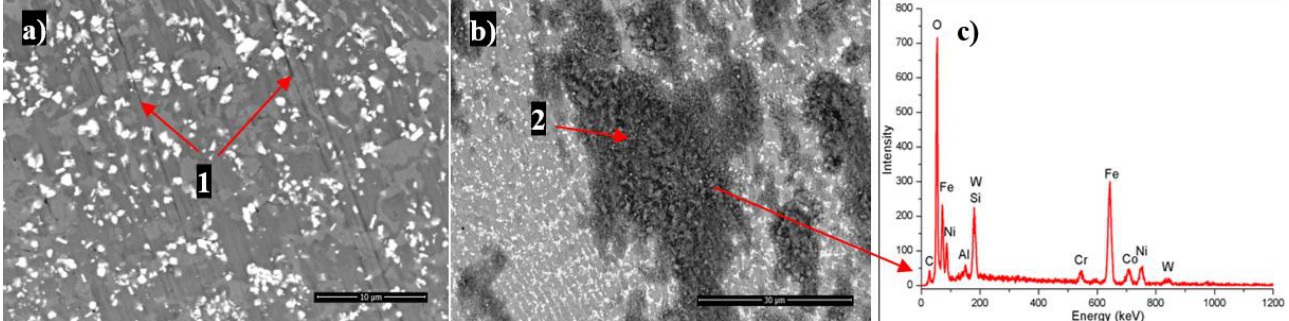
Figure 8. Back scattered electron micrograph of WC-Co/NiCrBSi wear scars after POD test ( a ); micro-ploughing–abrasive grooves (1), tribo-oxidation – migration of debris ( b ) along the surface (2), and EDX ( c ) spectra of debris agglomeration.